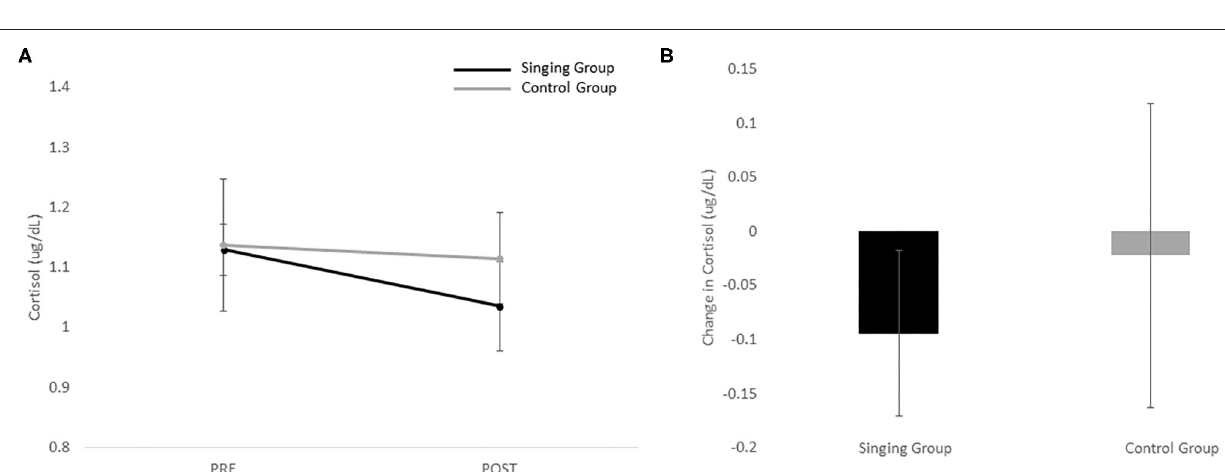
effect [ F (1) = 0.21, p = 0.65] for the motor UPDRS.